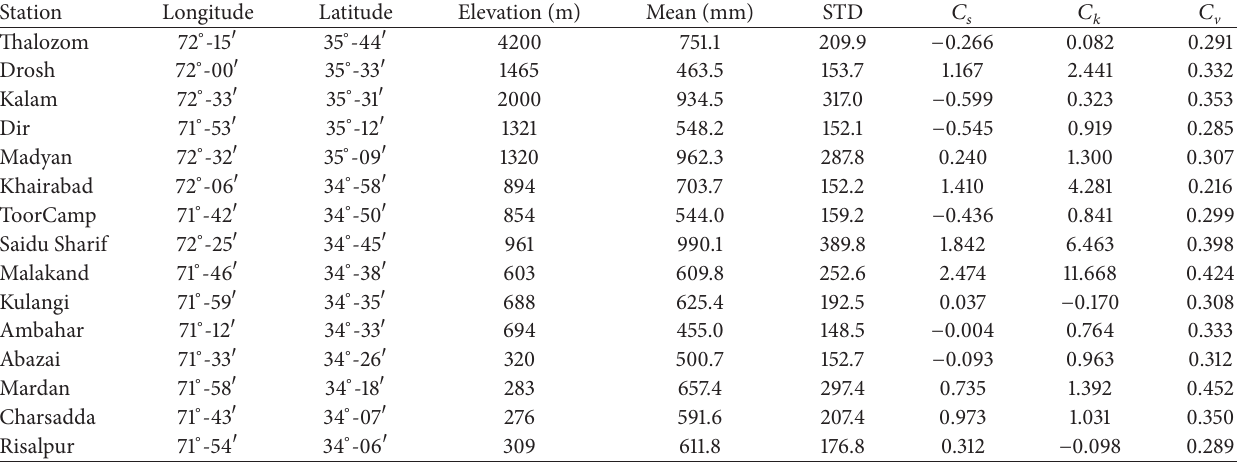
Table 2: Summary of geographic conditions and mean annual precipitation statistics for study